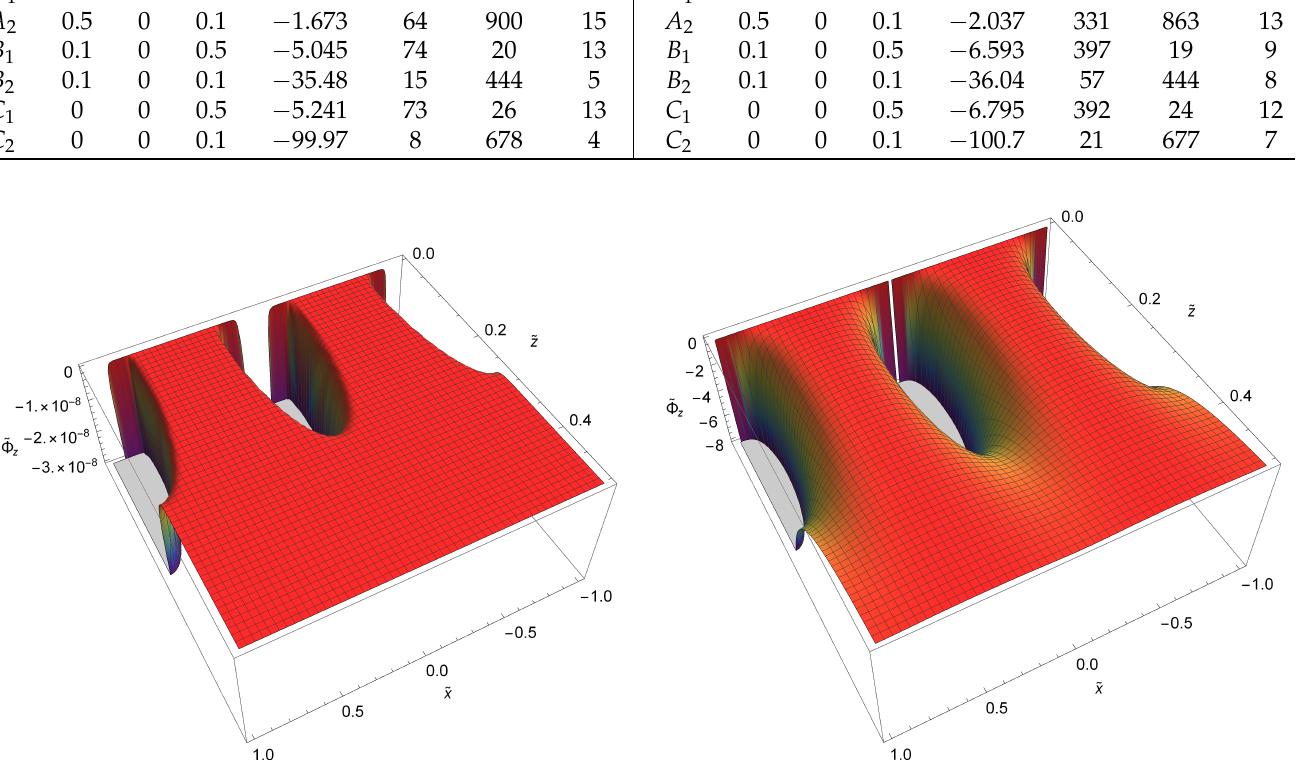
Figure 9. z -component of the rescaled force ˜ Φ z for ˜ λ eff = 0.01 and ˜ λ eff = 0.1 (left and right panels, respectively).